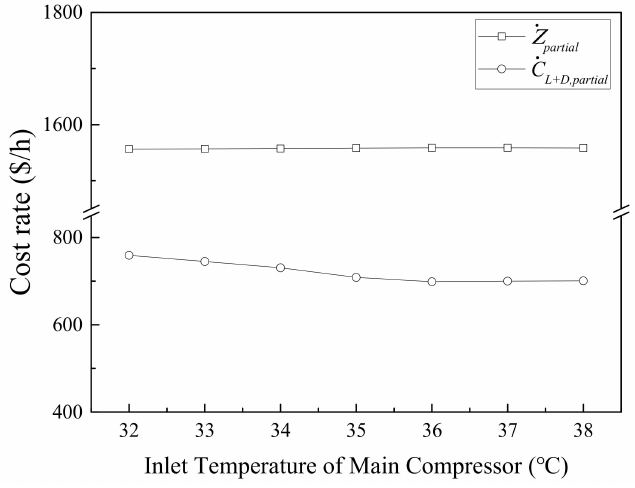
. . Z and C L + D with the partial-cooling